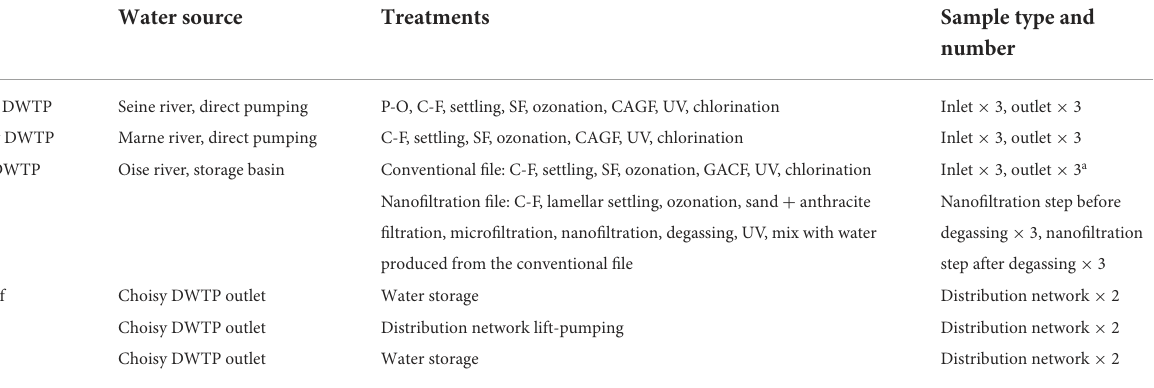
TABLE 1 Description of DWTP processes and sampling per